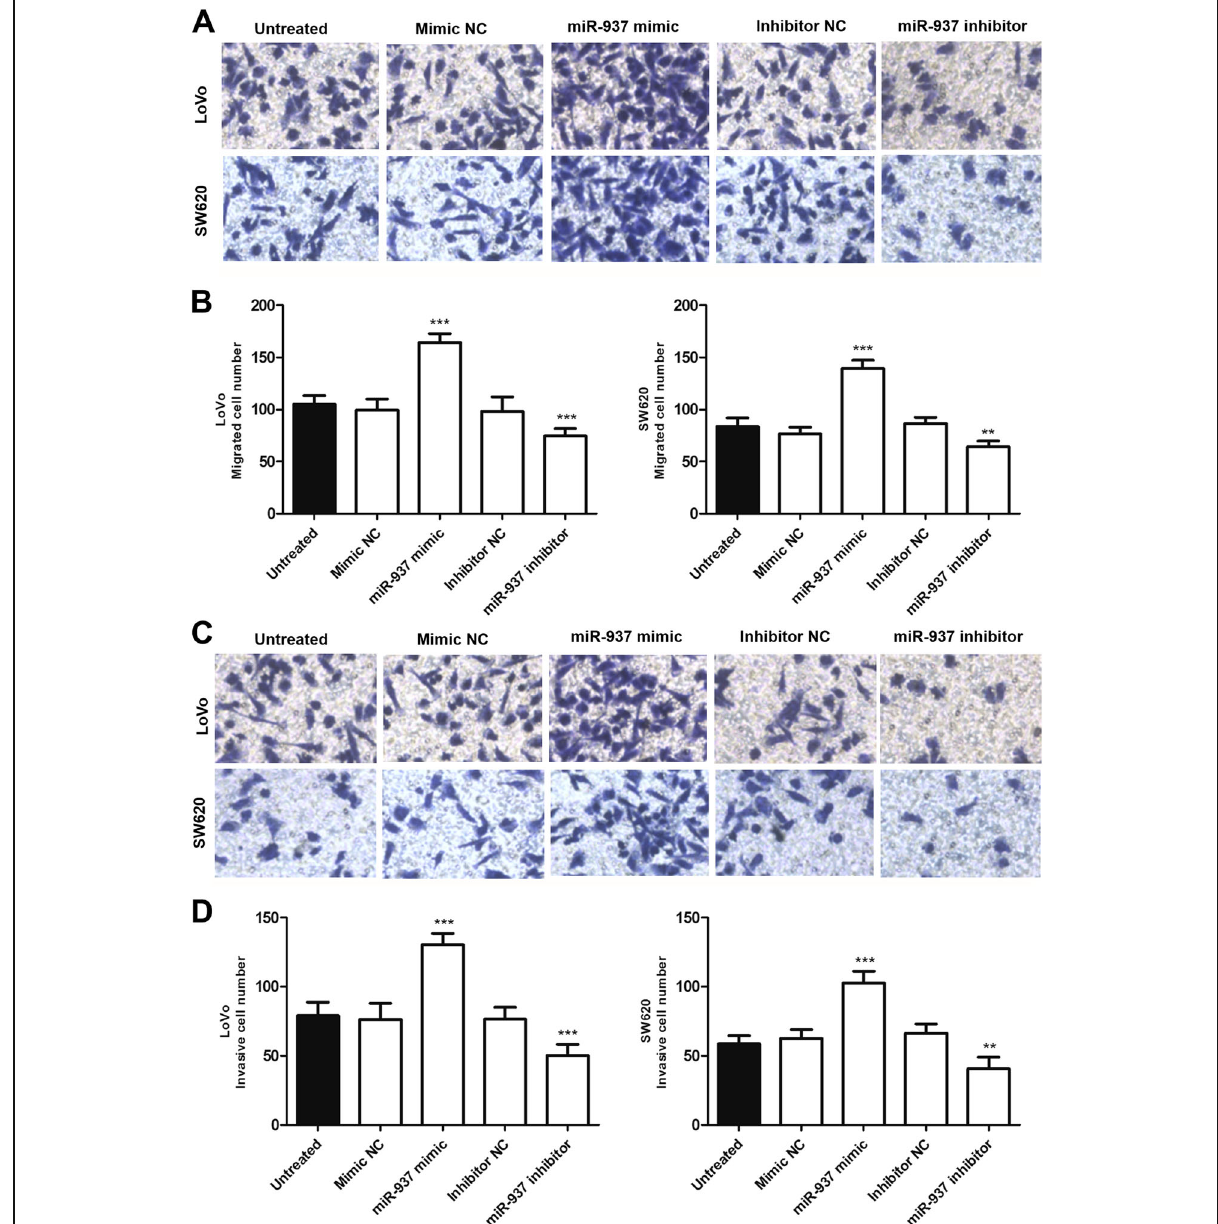
Fig. 4 Overexpression of miR-937 promotes the migratory and invasive capabilities, while the downregulation of miR-937 inhibits the migratory and invasive capabilities of colon cancer cells (LoVo and SW620), compared with untreated cells. a . Representative images of Transwell migration assay (magnification × 200). b . Transwell migration assay was applied to investigate migration ability. c . Representative images of Transwell invasion assay (magnification × 200). d . Transwell invasion assay was applied to investigate invasion ability. ** P < 0.01, *** P <